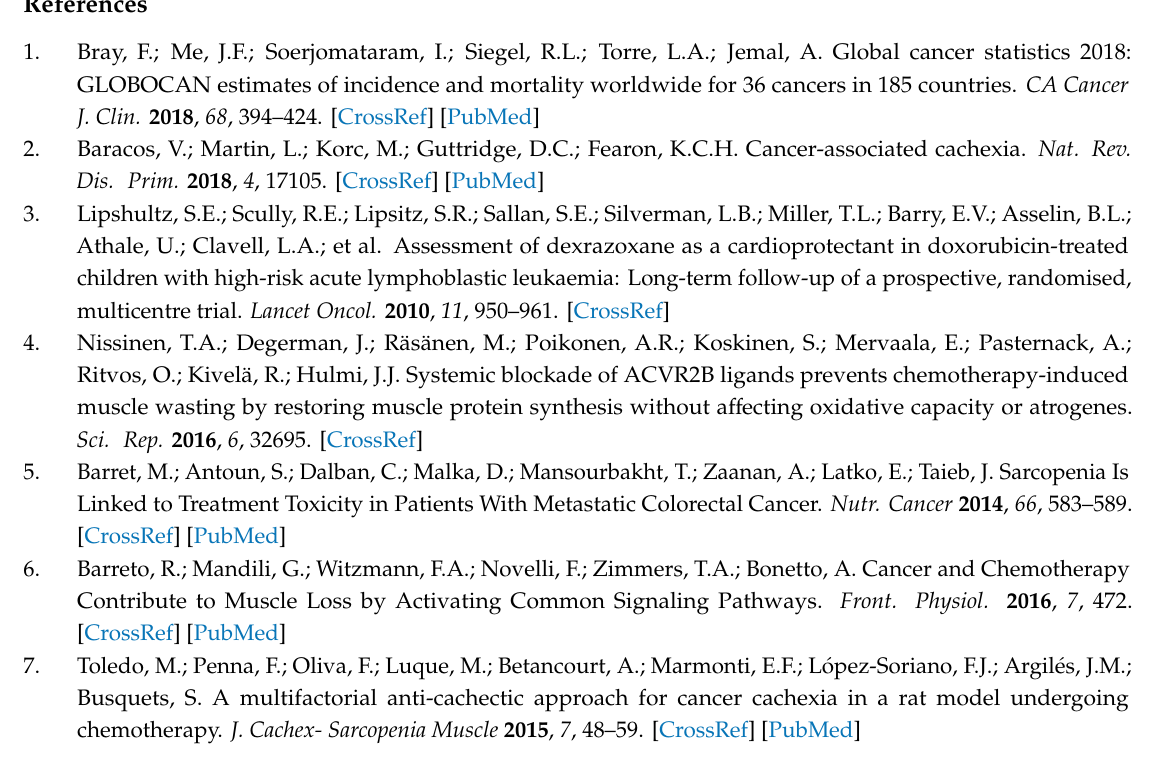
Table S1: Sequences of the primers used in real time-PCR, Table S2: E ff ects of only doxorubicin and the combination of doxorubicin plus endurance exercise on the muscle and adipose tissue weight. Table S3: Levels of pro- and anti-inflammatory cytokines in the gastrocnemius muscle after the chemotherapy treatment, Table S4: Serum parameters, Table S5: Glucose metabolism in tumor-bearing mice, Figure S1: Uncropped Western Blots of Figure 4, Figure S2: Uncropped Western Blots of Figure 5, Figure S3: Uncropped Western Blots of Figure 6, Figure S4: E ff ect of treatments on glucose metabolism immediately after the interruption of